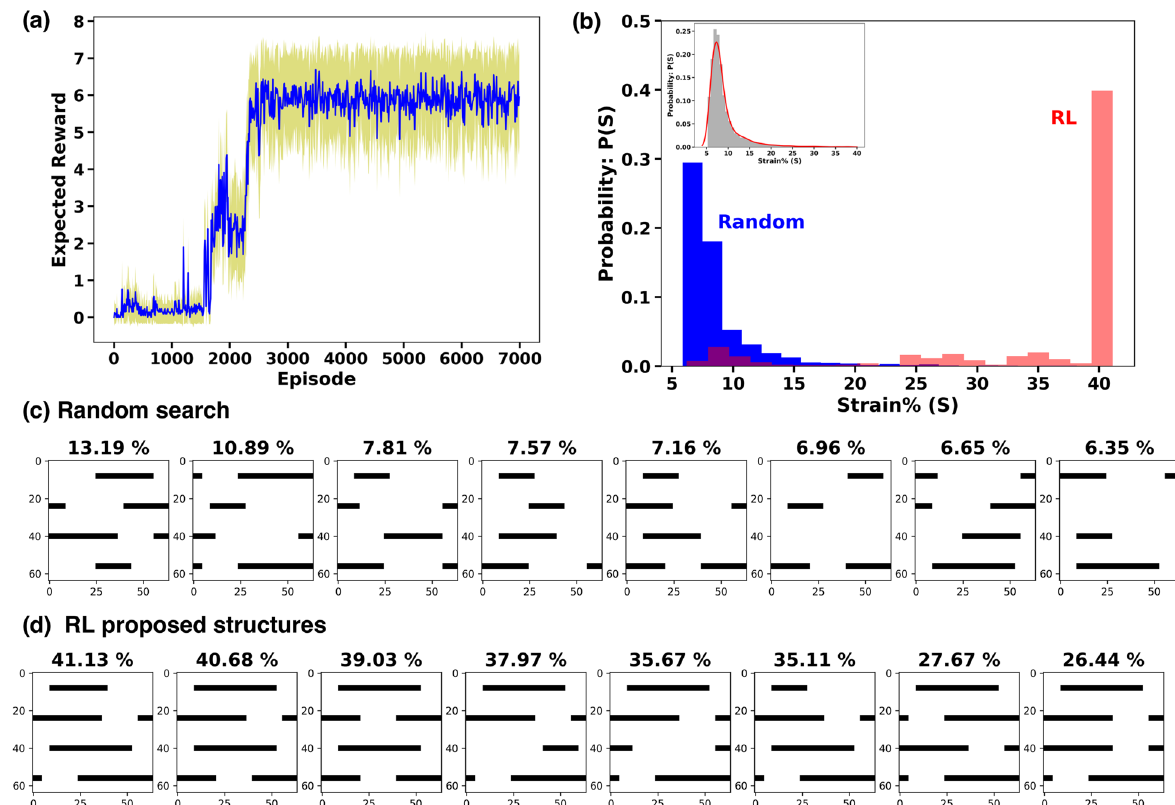
Fig. 3 Training and test results of RL agent with 4 cuts. a Expected reward (blue lines) and its variance (yellow) during the training of the RL agent for n = 4 with S T = 15% during trainin. b Probability density function (PDF) constructed by sampling 500 structures using random search (blue) and RL agent (red). Here, the inset shows the true PDF of strain for all the possible structures for n = 4, i.e., a structure state space consisting of 13 4 structures. c Several samples generated during random search along with their stretchability and d shows few samples proposed by the RL agent along with their